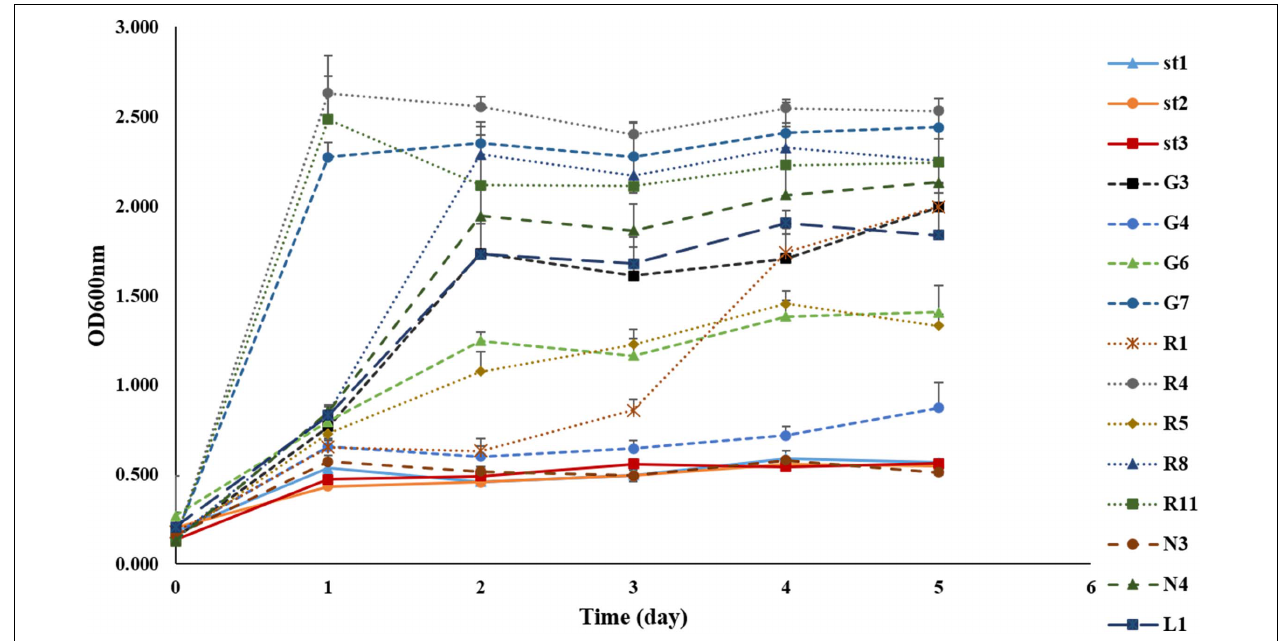
FIGURE 1 | Growth of 15 strains of lactic acid bacteria isolated from forage-specific fermented juice of lactic acid bacteria incubated at 50 ◦ C.